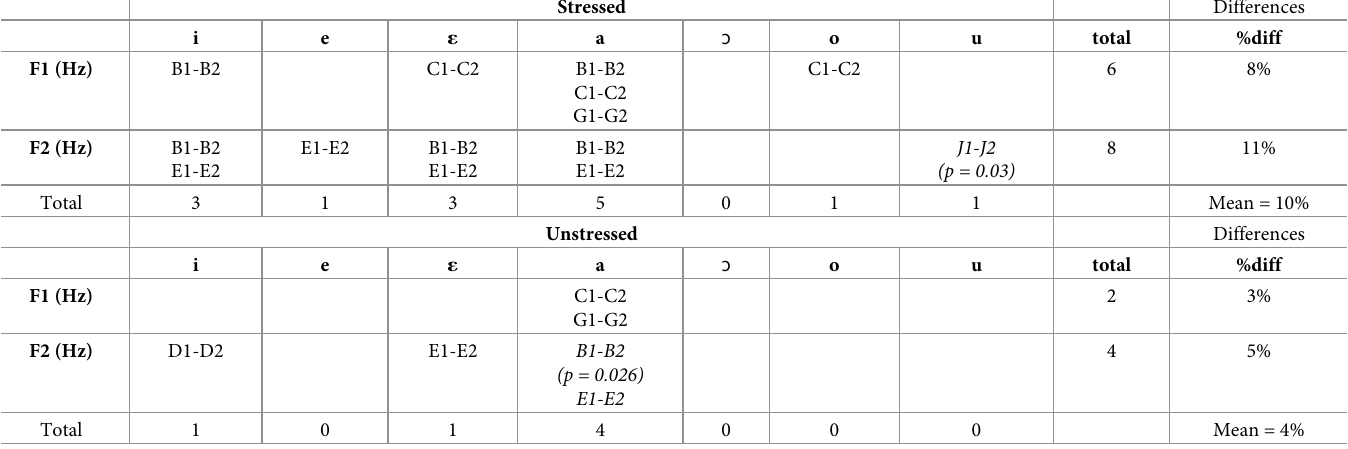
Table 3. Significant (p < 0.05/2) and marginally significant differences (p < 0.10/2) within identical twins for stressed and unstressed vowels. Two-tailed test with Bon- ferroni correction.